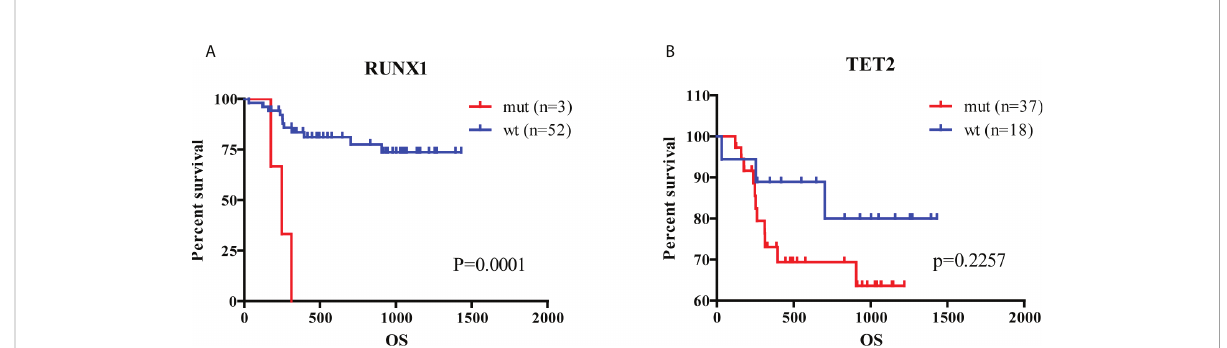
FIGURE 6 Analysis of hub genes and mutated genes in AML. (A) Kaplan-Meier estimates of the OS according to RUNX1 mutation status. (B) Kaplan-Meier estimates of the OS according to TET2 mutation status. (wt, wild type; mut,